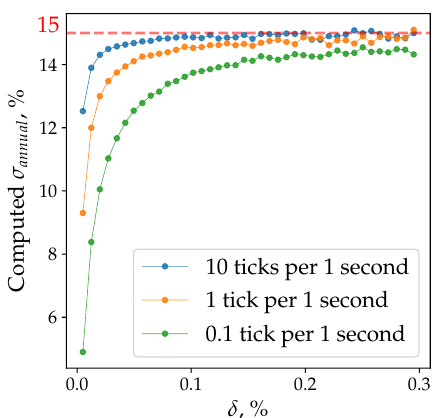
Figure 5. Instantaneous volatility of three time series generated by GBM with various tick frequencies and fixed volatility (15%). The volatility is computed by the directional-change approach (Equation (19)). Sizes of the directional change thresholds, used to calculate the volatility values, are put on the X-axis. Red dashed line marks the 15%